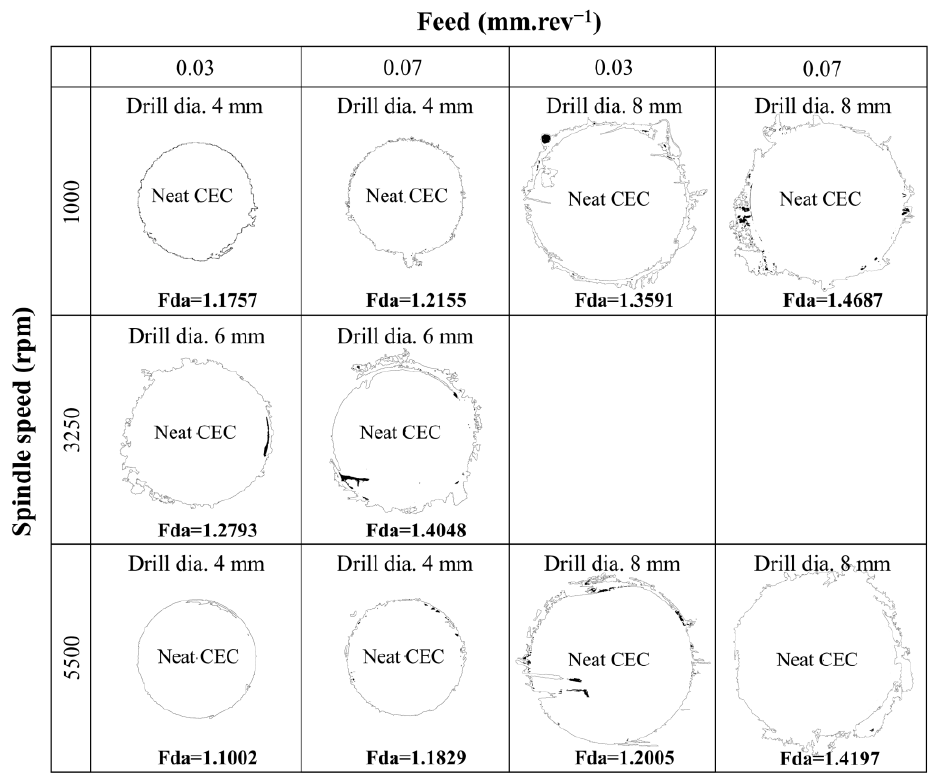
Figure 5. Delamination images of neat CEC under various drilling conditions.